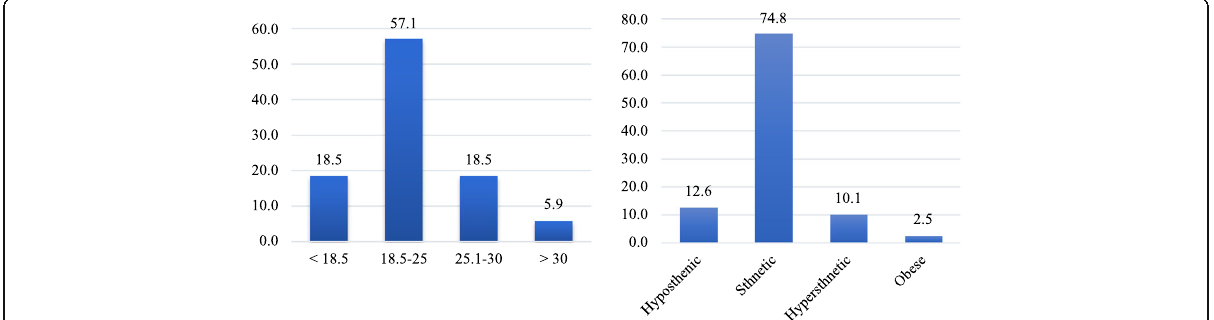
Fig. 4 Percent of BMI (left) and body built (right) of victims